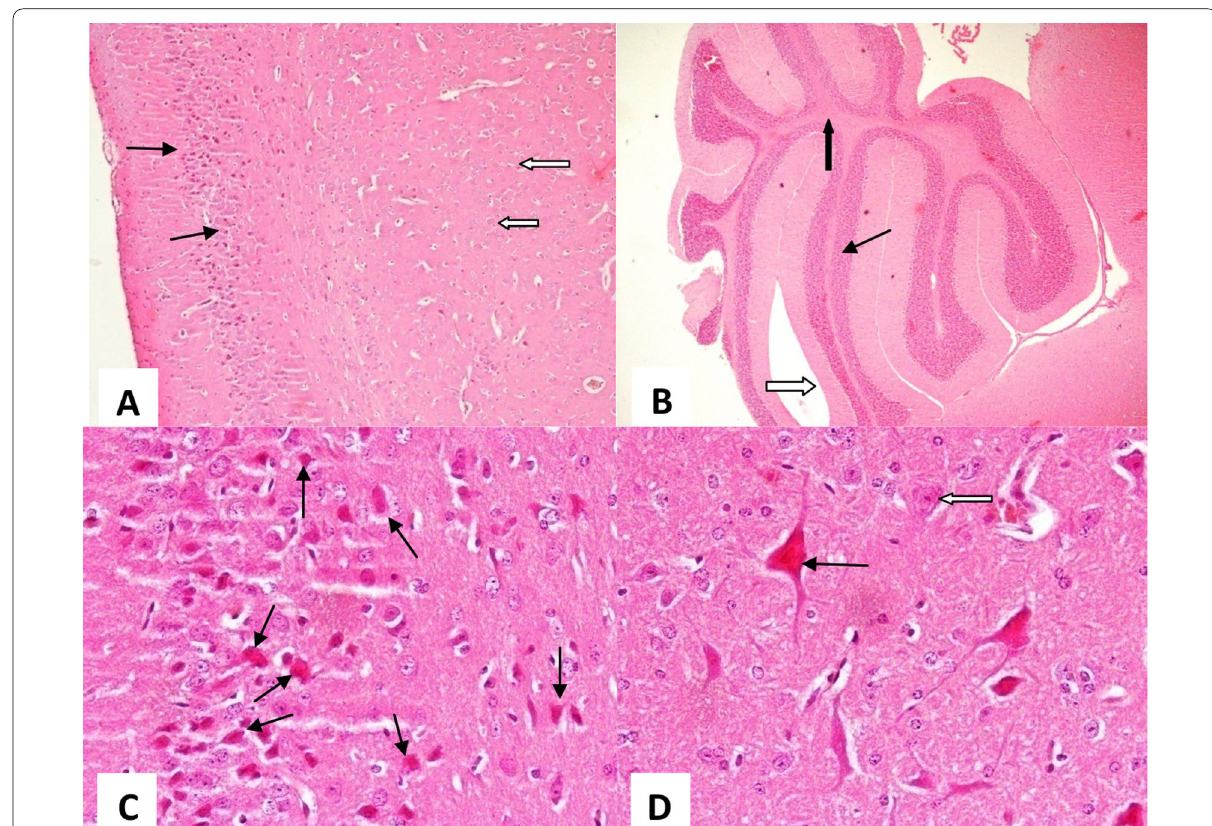
Fig. 4 A Brain tissue of normal mice showing cellular Purkinje cell layer (black arrows) and abundant cells within white matter (white arrows) (H&E X100). B Cerebellar tissue of normal mice showing granular cell layer (thin black arrow) in between molecular layer (white arrow) and white matter (thick black arrow) (H&E X100). C Brain tissue of normal mice showing numerous pigmented pyramidal neuronal cells (black arrows) (H&E X400). D Brain tissue of normal mice showing pyramidal neuronal cells with abundant pigment within cytoplasm (black arrow), together with other non-pigmented neuronal cells (white arrow) (H&E X400)